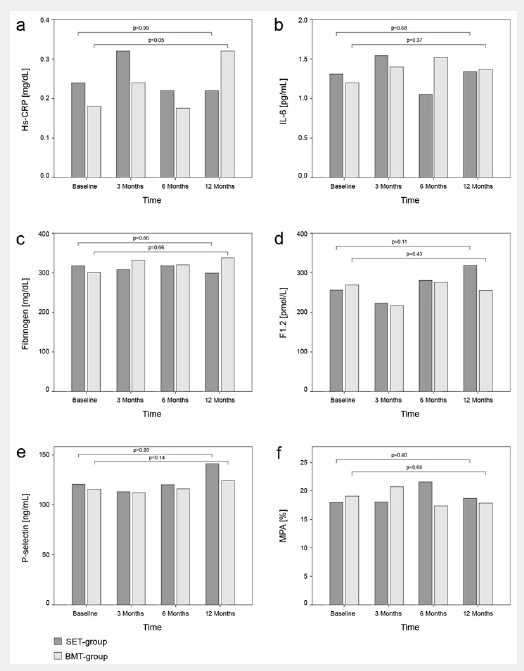
Bar chart indicating median values of markers of high sensitivity C- reactive protein (hs-CRP), interleukin-6 (IL-6), fibrinogen, soluble P- selectin, prothrombin fragment 1+2 (F1.2) and monocyte-platelet aggregates (MPA) at baseline, after three, six and twelve months. Friedman test for distribution free, repeated-measures analysis of variance was used to test for significant changes within the groups over time